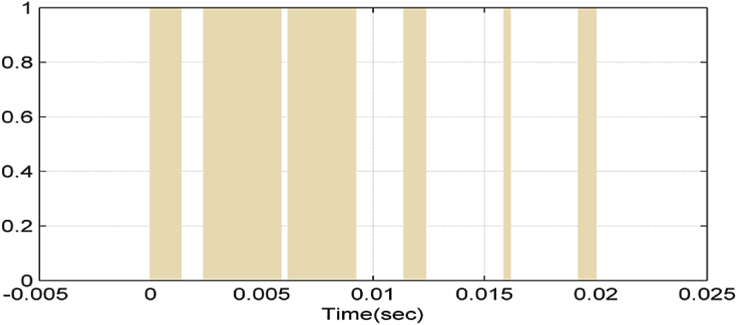
TR2 gate signal.